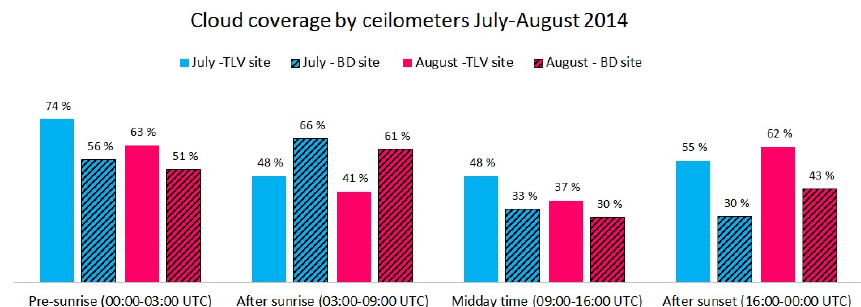
Figure 13. Cloud cover based on half-hourly averaged ceilometer plots from the TLV (onshore) and BD (inland) sites between July and August 2014. Each half hourly profile was scored as follows: 1 for cloud presence and 0 for no clouds. The estimation was done on days with complete data from both ceilometers (20 days in July and 22 days in